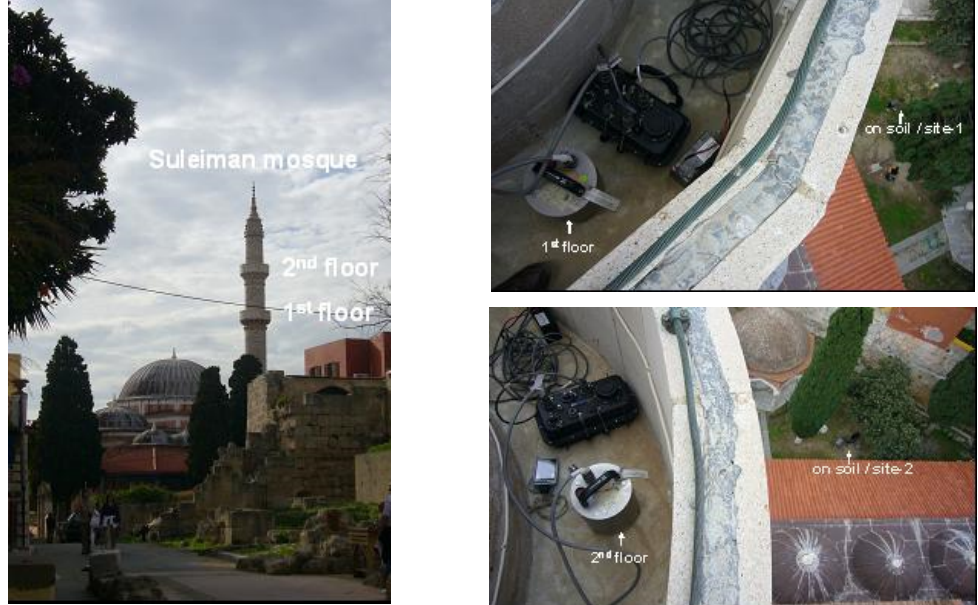
Figure 6. The instruments were placed on the ground soil and on the two balconies of the minaret [52].